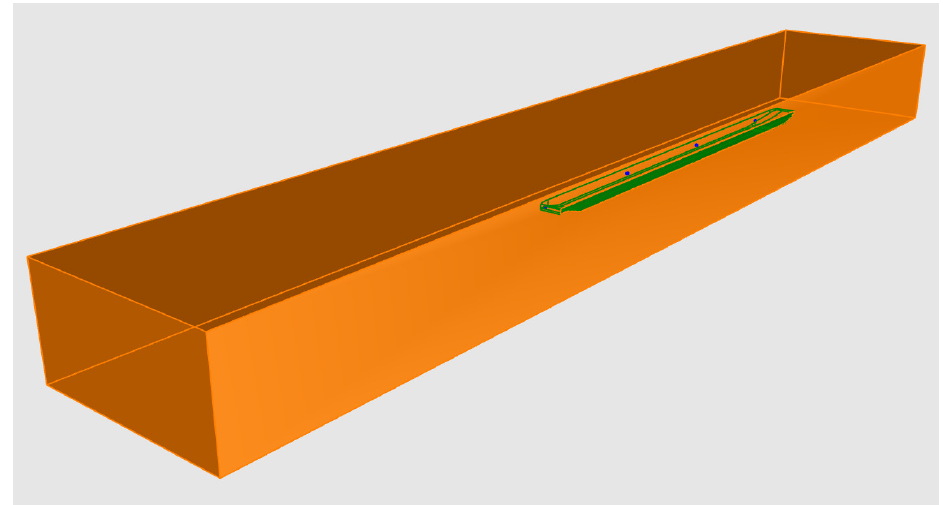
Figure 2. 3D geometry of a typical CFD domain (Layout E, deep water). Source: Authors.